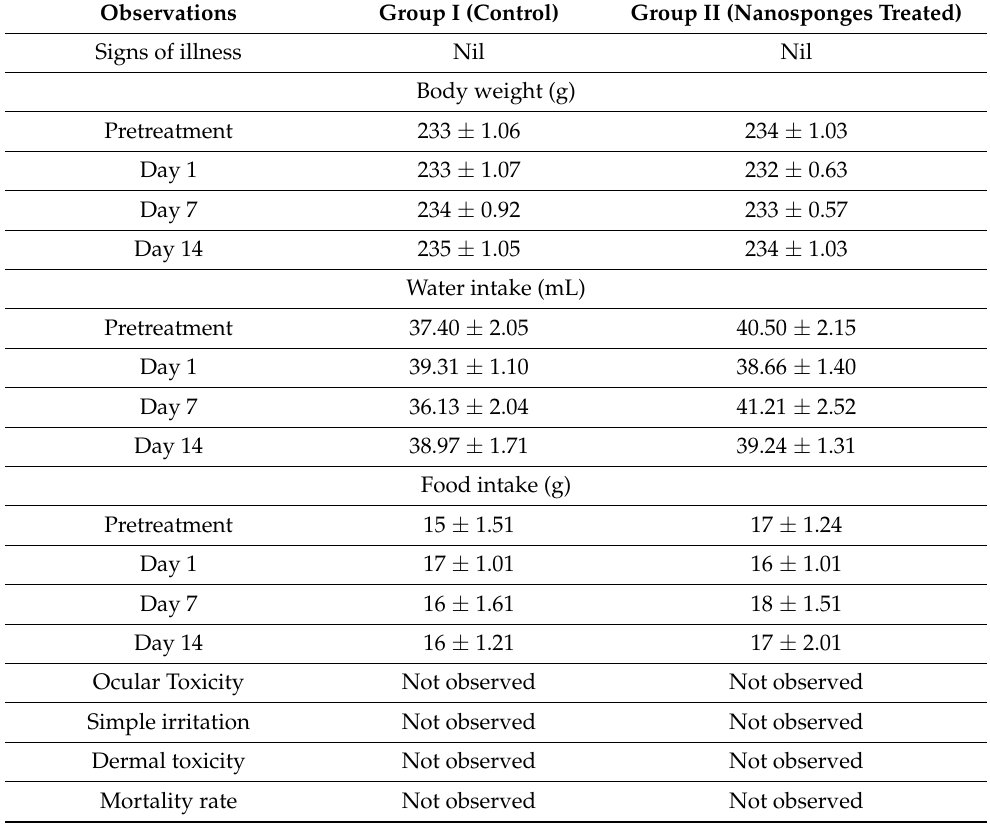
Table 3. Clinical findings of an acute oral toxicity study of developed